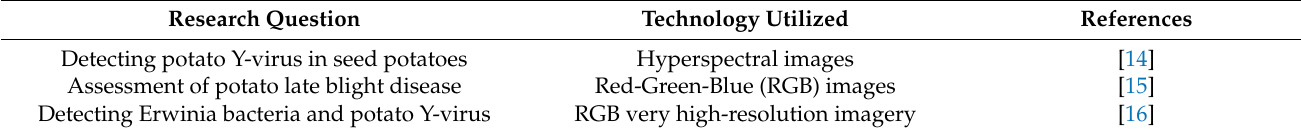
Table 1. Several other studies on the utilization of unmanned vehicles (UAV) for the detection of the damage caused by potato diseases